Question: Provide a one-line summary of what is displayed.
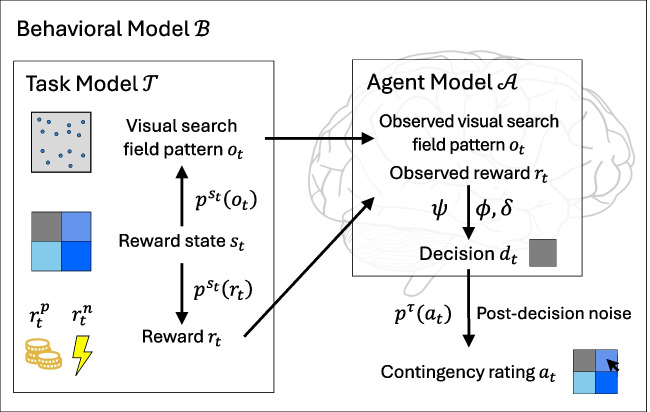
Answer: Conceptual overview of the agent-based behavioral modeling framework. In general, our agent-based behavioral modeling framework differentiates between a task model \documentclass[12pt]{minimal} \usepackage{amsmath} \usepackage{wasysym} \usepackage{amsfonts} \usepackage{amssymb} \usepackage{amsbsy} \usepackage{mathrsfs} \usepackage{upgreek} \setlength{\oddsidemargin}{-69pt} \begin{document}$$\mathcal {T}$$\end{document} T , an agent model \documentclass[12pt]{minimal} \usepackage{amsmath} \usepackage{wasysym} \usepackage{amsfonts} \usepackage{amssymb} \usepackage{amsbsy} \usepackage{mathrsfs} \usepackage{upgreek} \setlength{\oddsidemargin}{-69pt} \begin{document}$$\mathcal {A}$$\end{document} A , and their joint embedding in a behavioral model \documentclass[12pt]{minimal} \usepackage{amsmath} \usepackage{wasysym} \usepackage{amsfonts} \usepackage{amssymb} \usepackage{amsbsy} \usepackage{mathrsfs} \usepackage{upgreek} \setlength{\oddsidemargin}{-69pt} \begin{document}$$\mathcal {B}$$\end{document} B . The task model specifies key aspects and the structure of the experimental task. In the present work, the task model includes a trial-specific reward state \documentclass[12pt]{minimal} \usepackage{amsmath} \usepackage{wasysym} \usepackage{amsfonts} \usepackage{amssymb} \usepackage{amsbsy} \usepackage{mathrsfs} \usepackage{upgreek} \setlength{\oddsidemargin}{-69pt} \begin{document}$$s_t$$\end{document} s t , a trial-specific observable visual search field pattern \documentclass[12pt]{minimal} \usepackage{amsmath} \usepackage{wasysym} \usepackage{amsfonts} \usepackage{amssymb} \usepackage{amsbsy} \usepackage{mathrsfs} \usepackage{upgreek} \setlength{\oddsidemargin}{-69pt} \begin{document}$$o_t$$\end{document} o t , and a trial-specific reward as defined by a positive ( \documentclass[12pt]{minimal} \usepackage{amsmath} \usepackage{wasysym} \usepackage{amsfonts} \usepackage{amssymb} \usepackage{amsbsy} \usepackage{mathrsfs} \usepackage{upgreek} \setlength{\oddsidemargin}{